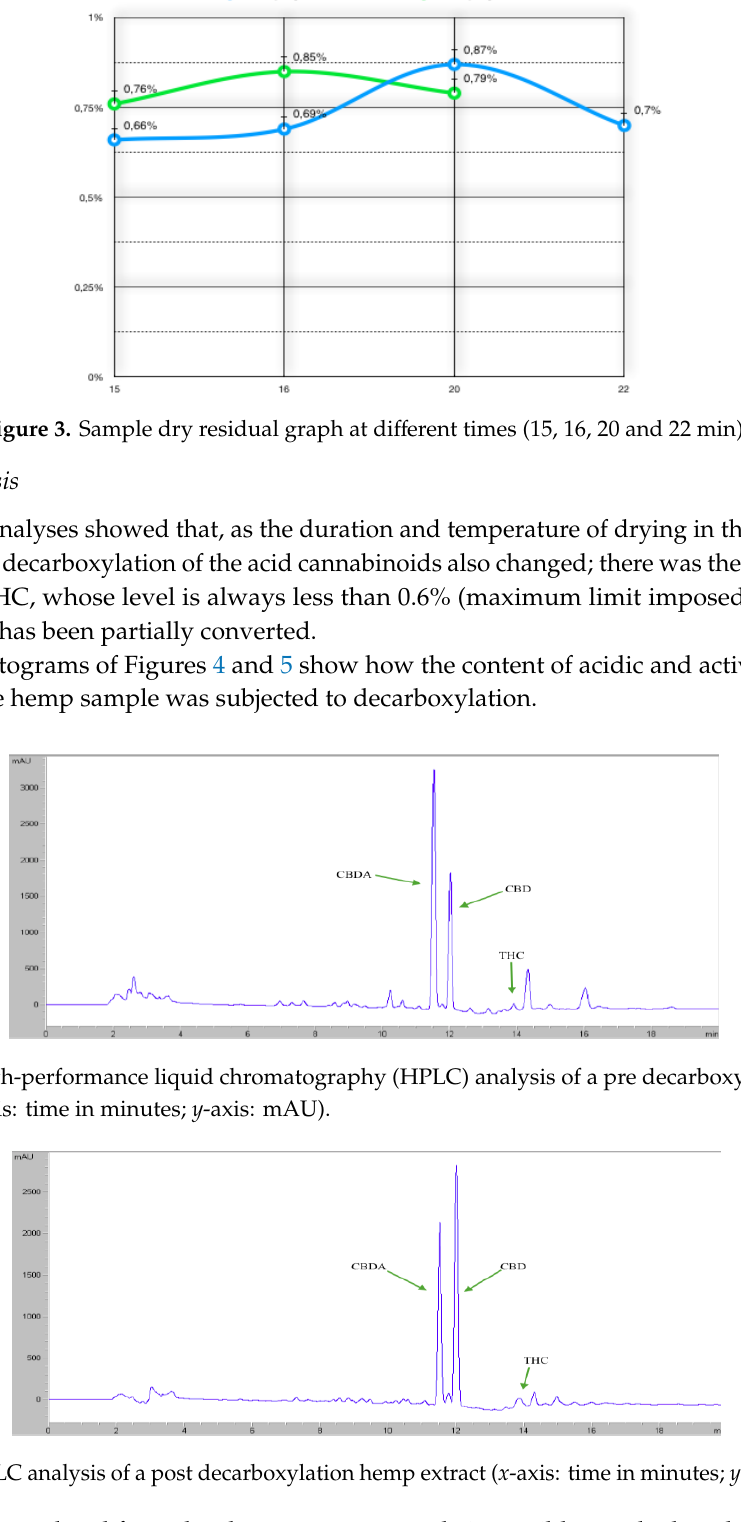
Table 3. Percentage of cannabinoids contained in the various hemp extracts.